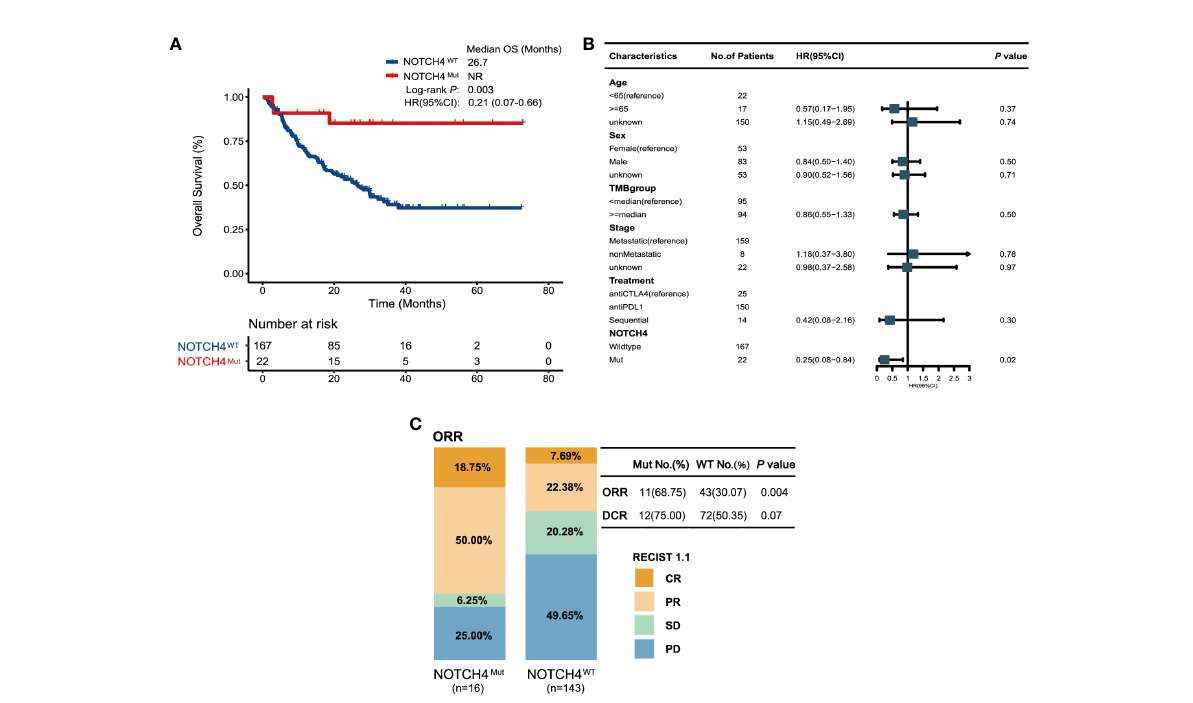
FIGURE 3 Validation of the predictive function of NOTCH4 mutations. (A) Kaplan – Meier survival analysis comparing OS between NOTCH4-Mut and NOTCH4-Wt patients in the validation cohort. NR, not reached. (B) Multivariate Cox regression analysis of NOTCH4 mutations with age, gender, stage (metastasis, means distant metastases, including IV stage with M1a, M1b, and M1c vs non-metastasis, means without distant metastases including IIIC stage and IV stage with M0) and TMB status were considered. Square data markers indicate estimated hazard ratios. Error bars represent 95% CIs. (C) The ratio of patients with complete response (CR), partial response (PR), stable disease (SD), and progression disease (PD) treated with ICIs in NOTCH4-Mut and NOTCH4-Wt group. P < 0.05 by Fisher ’ s exact test. There are 159 patients available to evaluate clinical bene fi